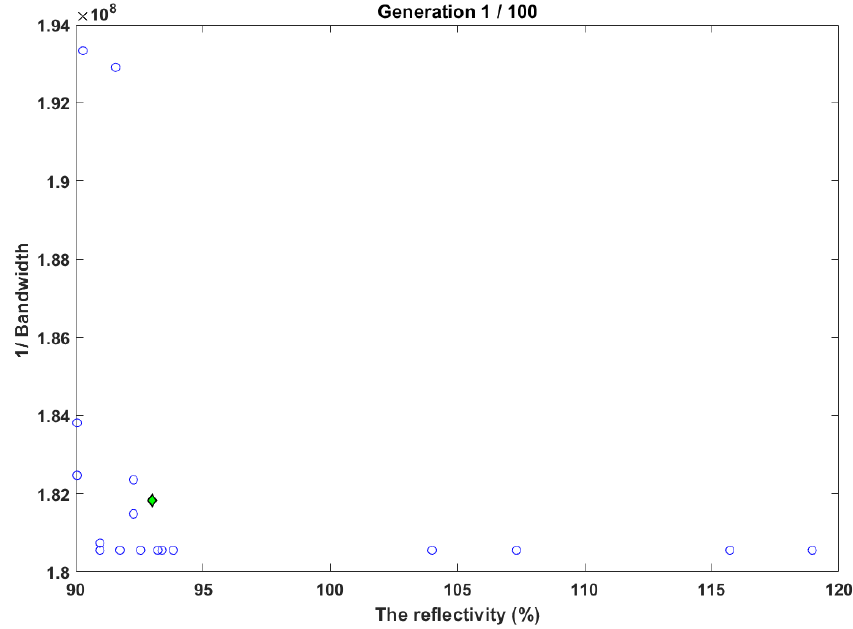
Figure 7. The testing RNSGA-II for increasing the reflectivity and increasing the bandwidth.